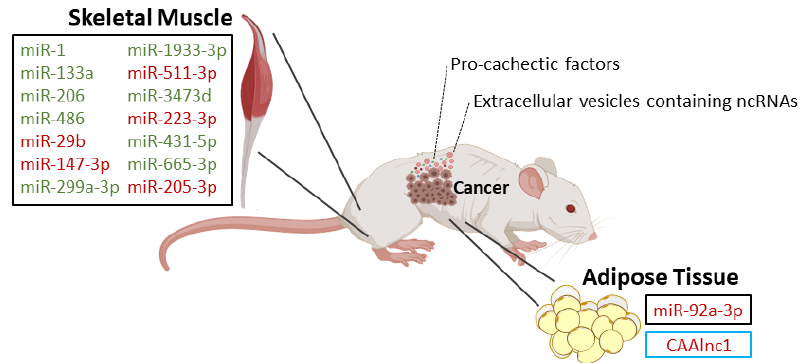
Figure 1. Dysregulated non-coding RNAs (ncRNAs) during muscle and adipose tissue wasting in mouse models of cancer cachexia: Squares in black refer to microRNAs and in blue refer to long non-coding RNAs. Upregulated non-coding RNAs are in red and downregulated non-coding RNAs are in green.